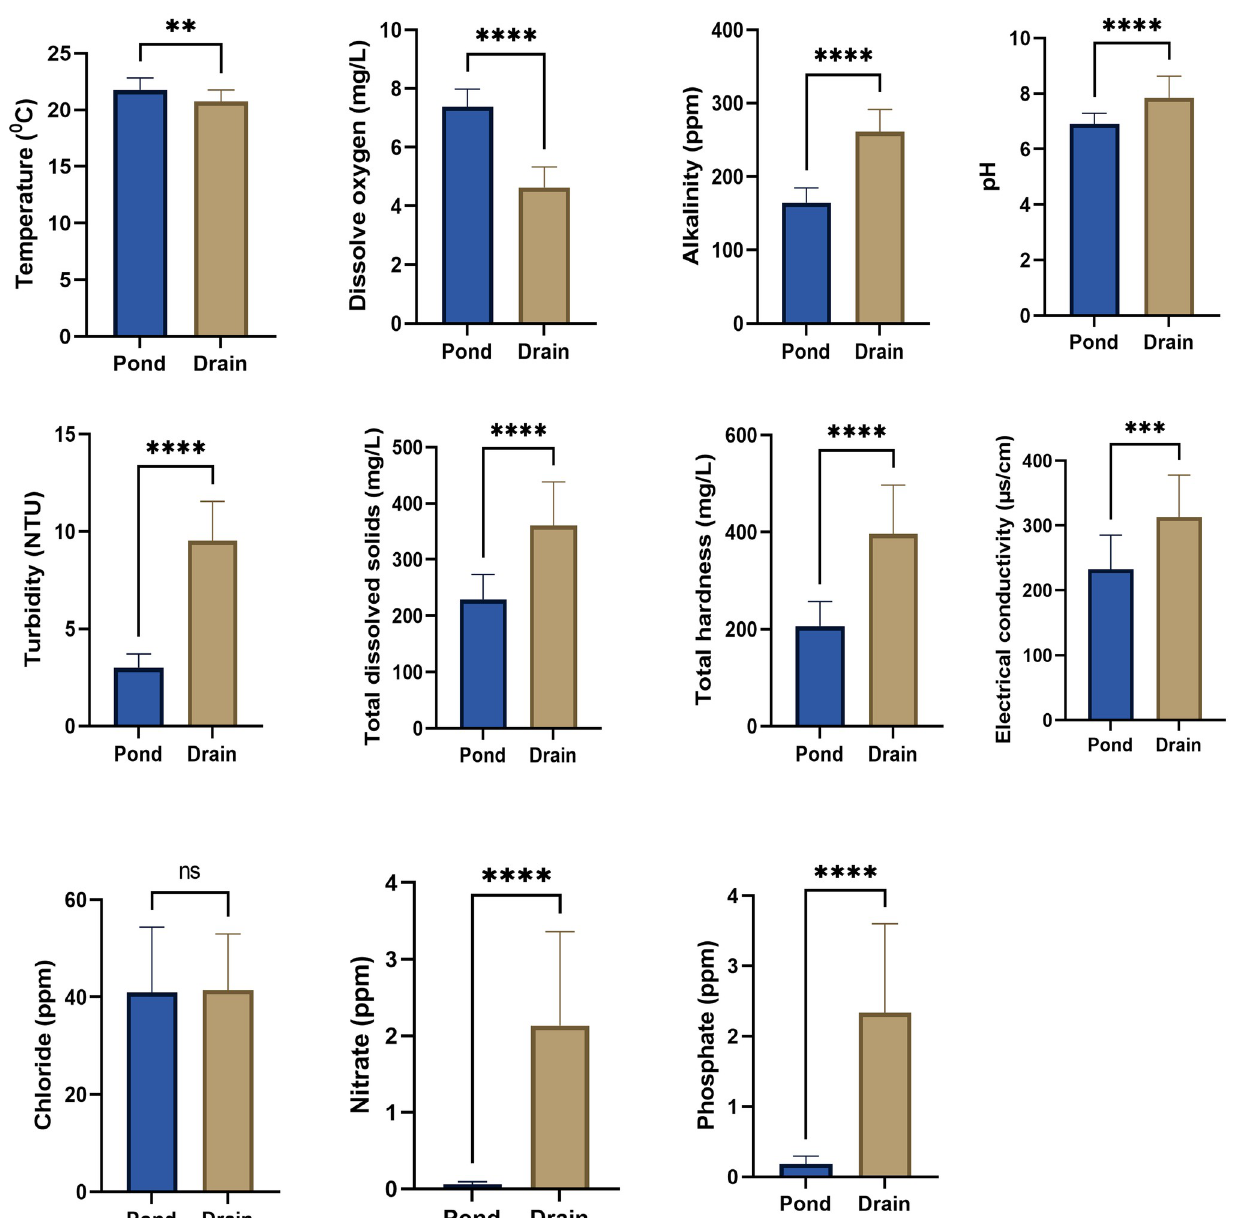
Fig 5. Physico-chemical parameters of different habitat types during winter season. An asterisk above given bar indicates significant difference. ‘ ���� ’ indicates p < 0.0001, ‘ ��� ’ indicates p < 0.001, ‘ �� ’ indicates p < 0.01, ‘ns’ indicates p > 0.05.